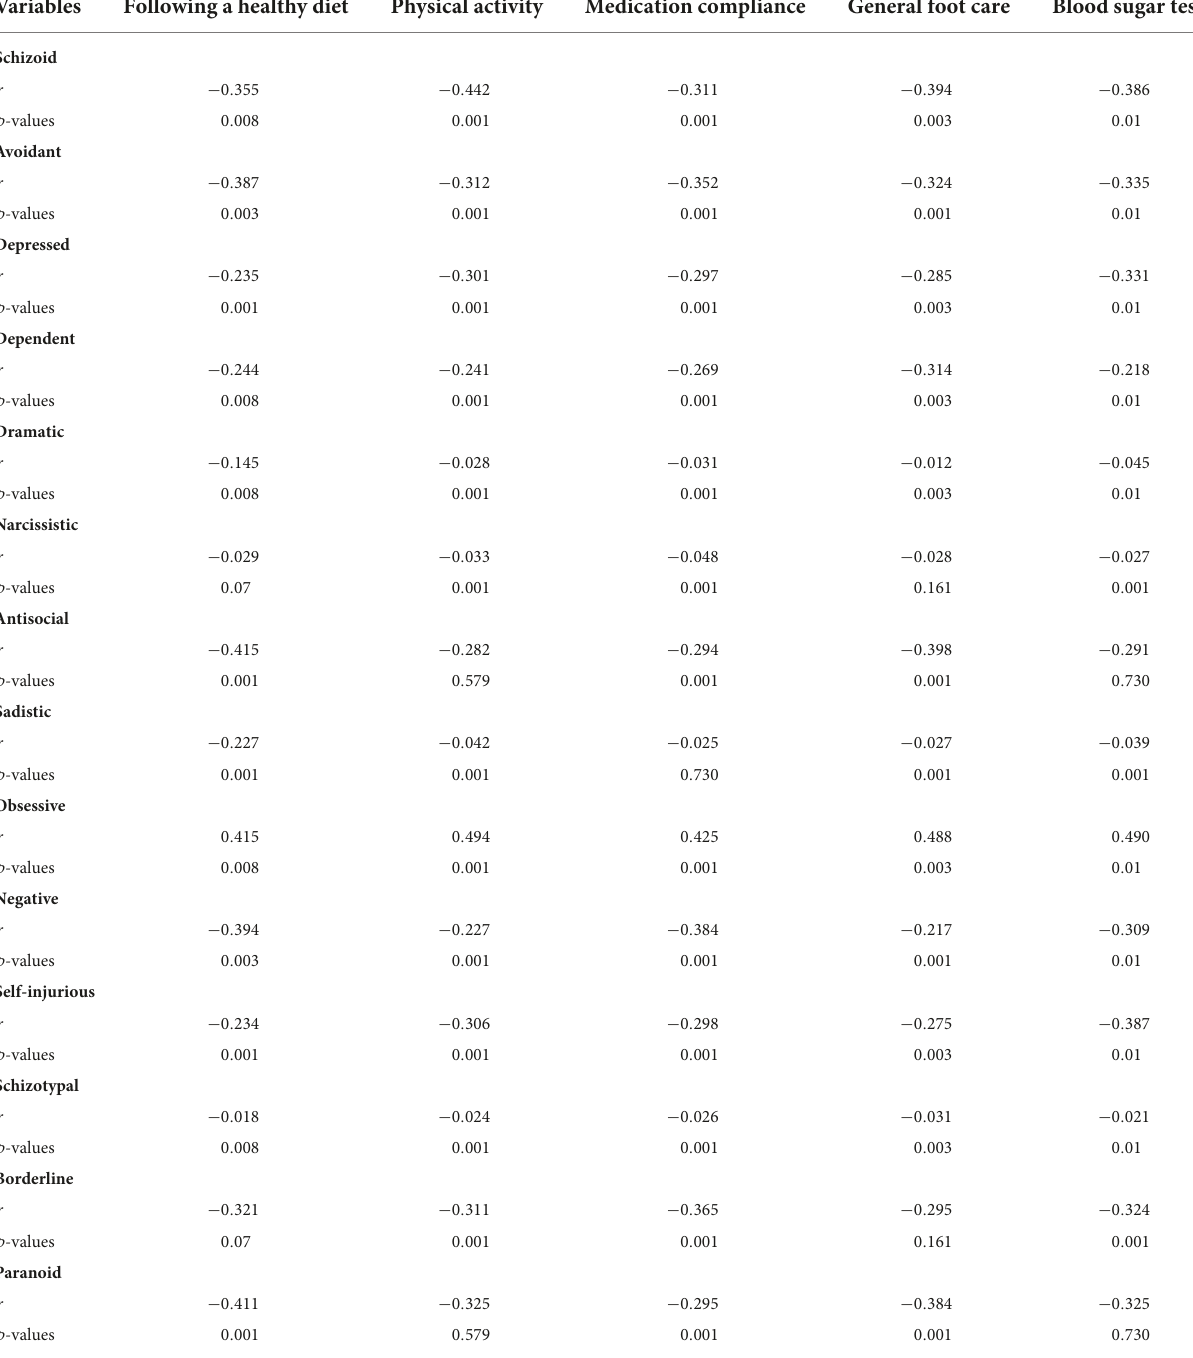
TABLE 4 Relationship between self-care dimensions and personality